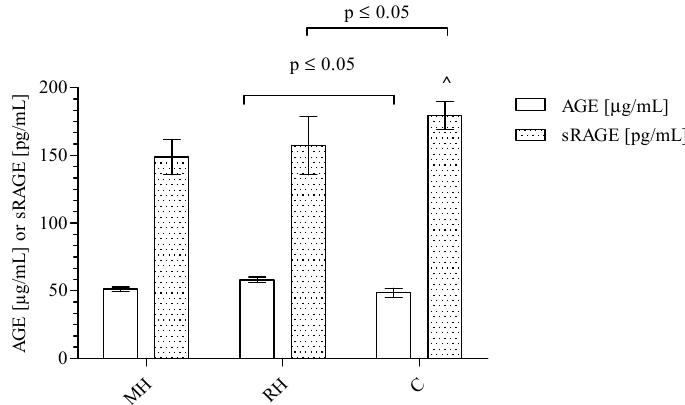
Figure 1. The level of AGEs and sRAGE in the blood of MH, RH, and C groups. The results are presented as mean and standard deviation. The AGEs and sRAGE levels were compared using the Kruskal-Wallis test followed by Dunn’s multiple comparison test. p ≤ 0.05 was considered statistically significant.